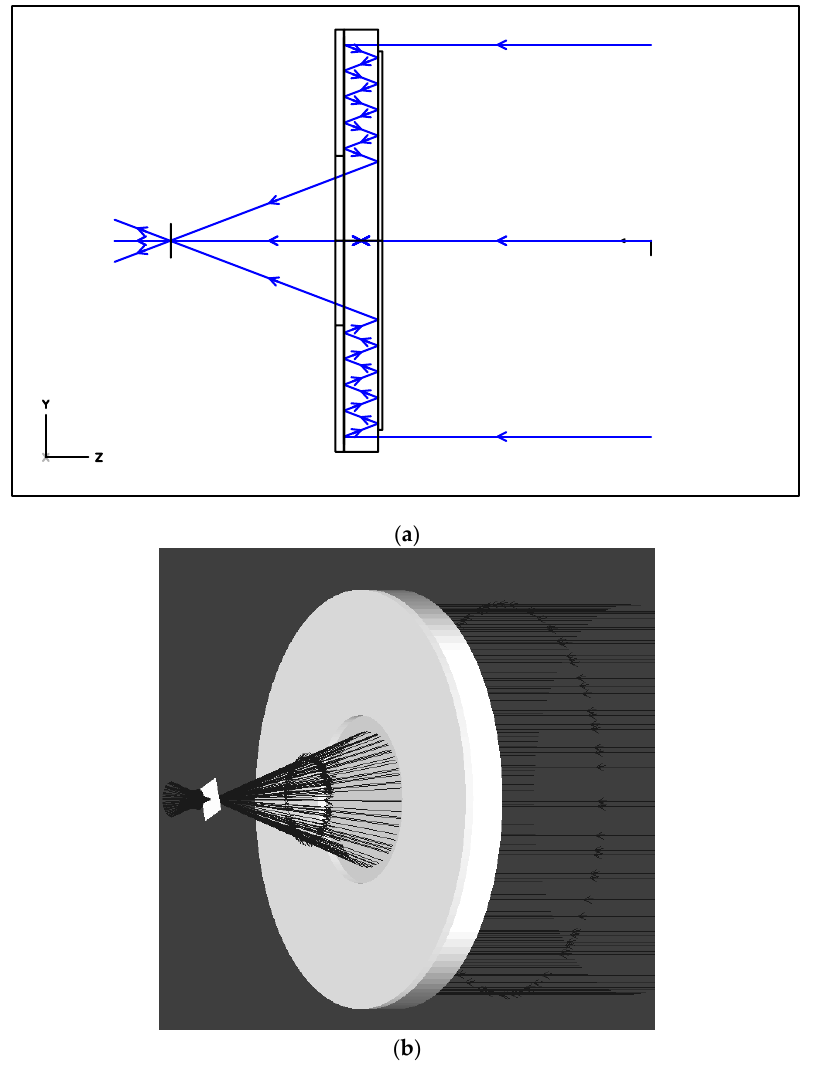
Figure 7. Ray tracing through a planar annular imaging objective. ( a ) Two-dimensional; ( b ) Ray tracing through a planar annular imaging objective. ( a ) Two-dimensional;